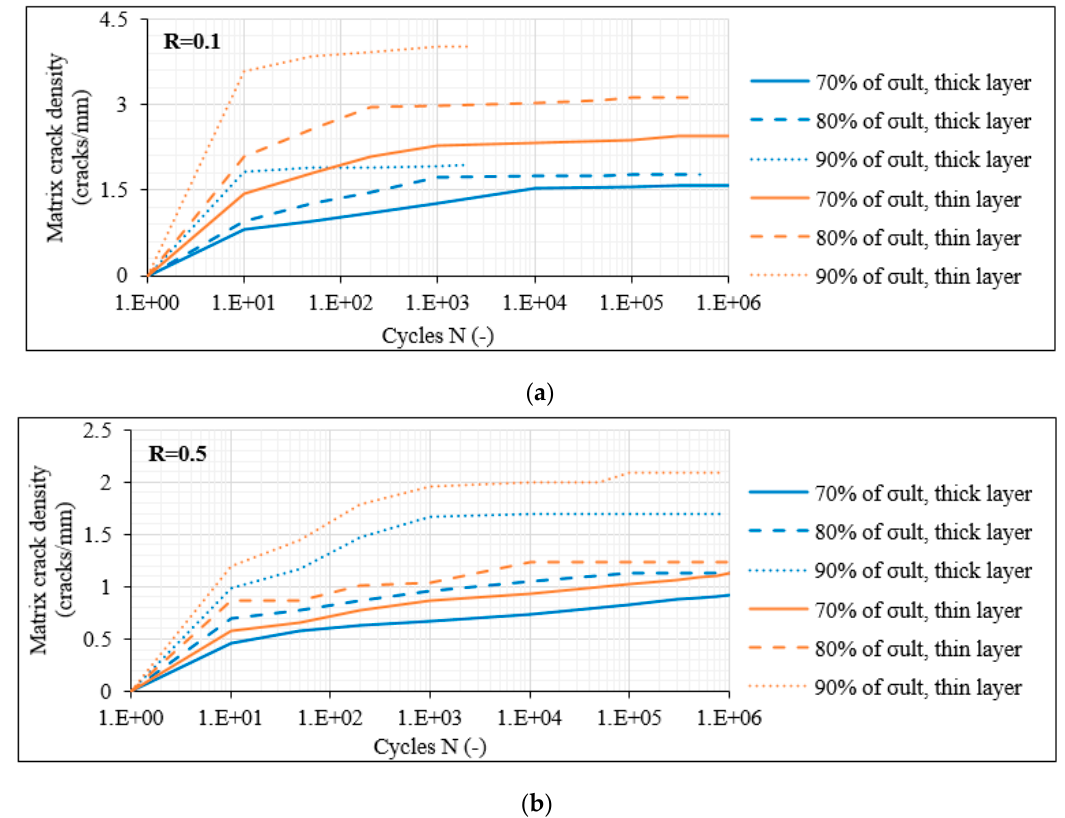
Figure 9. Matrix crack density versus N in [0°/60°] 2s laminates for ( a ) R = 0.1 and ( b ) R = 0.5.